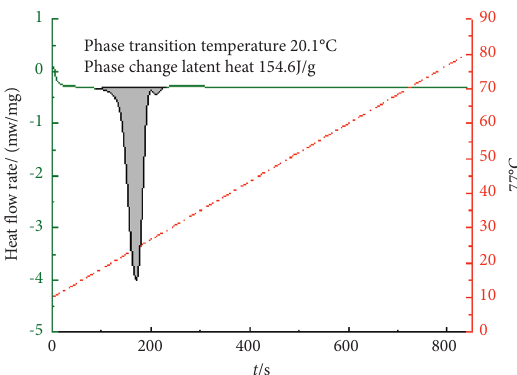
Figure 8: TD-MA :LA is the DSC curve of TD-MA-LA at 6.2:3.8.